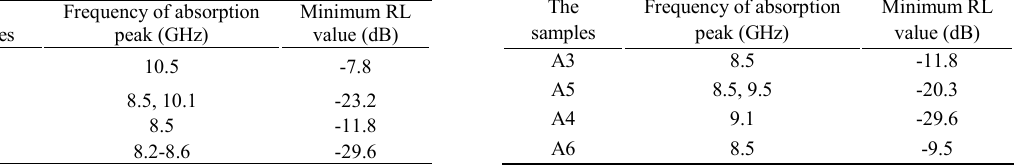
Table 3. Microwave absorption properties of the samples with different The samples